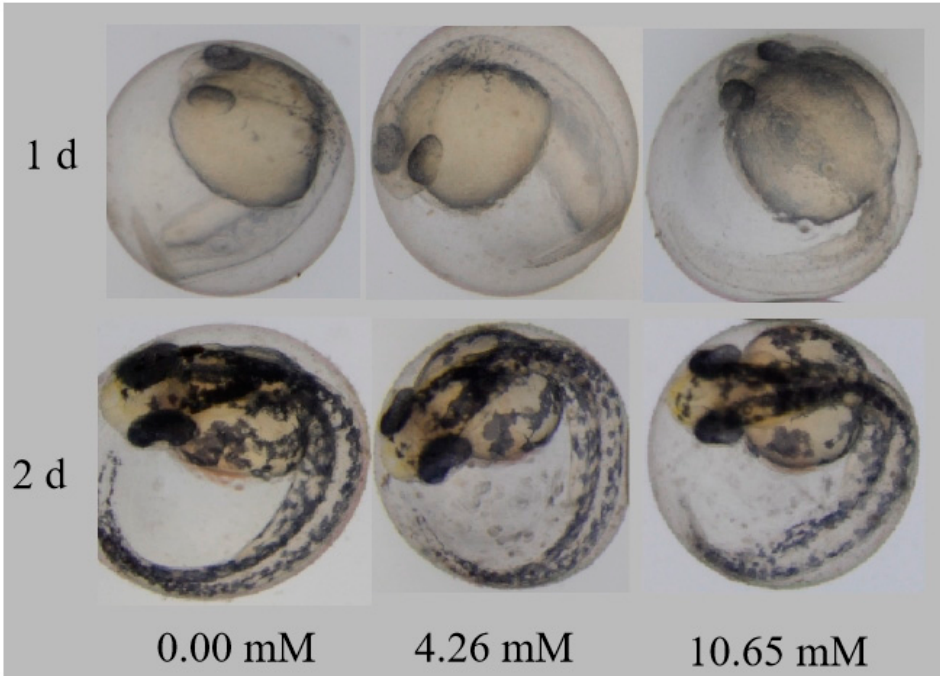
Figure 8. Teratogenic effect of PFLX on a zebrafish embryo.